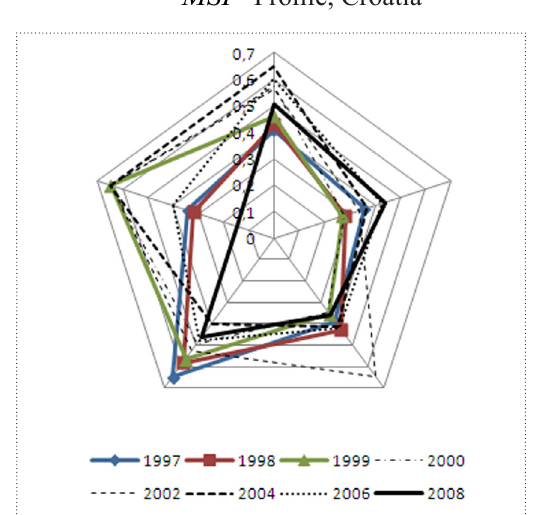
Figure 3. Comparison of MSP profiles of certain countries (based on our own